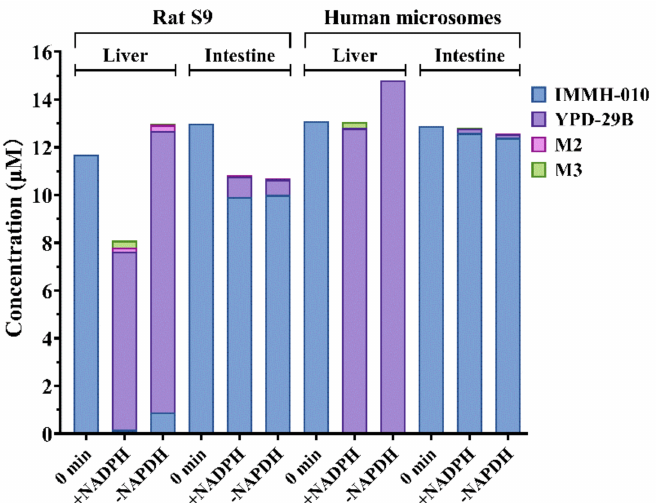
Figure 5. IMMH-010 metabolism in liver and intestine S9 fractions and microsomes. IMMH-010 (10 µ M) was incubated with rat liver and intestinal S9 homogenate protein (1 mg protein/mL) and with human liver and intestinal microsomes (0.2 mg protein/mL) in a final volume of 0.2 mL Tris-HCl buffer (50 mM, pH 7.4) containing 5 mM MgCl 2 . The incubations were performed in duplicate in the presence and absence of an NADPH regenerating